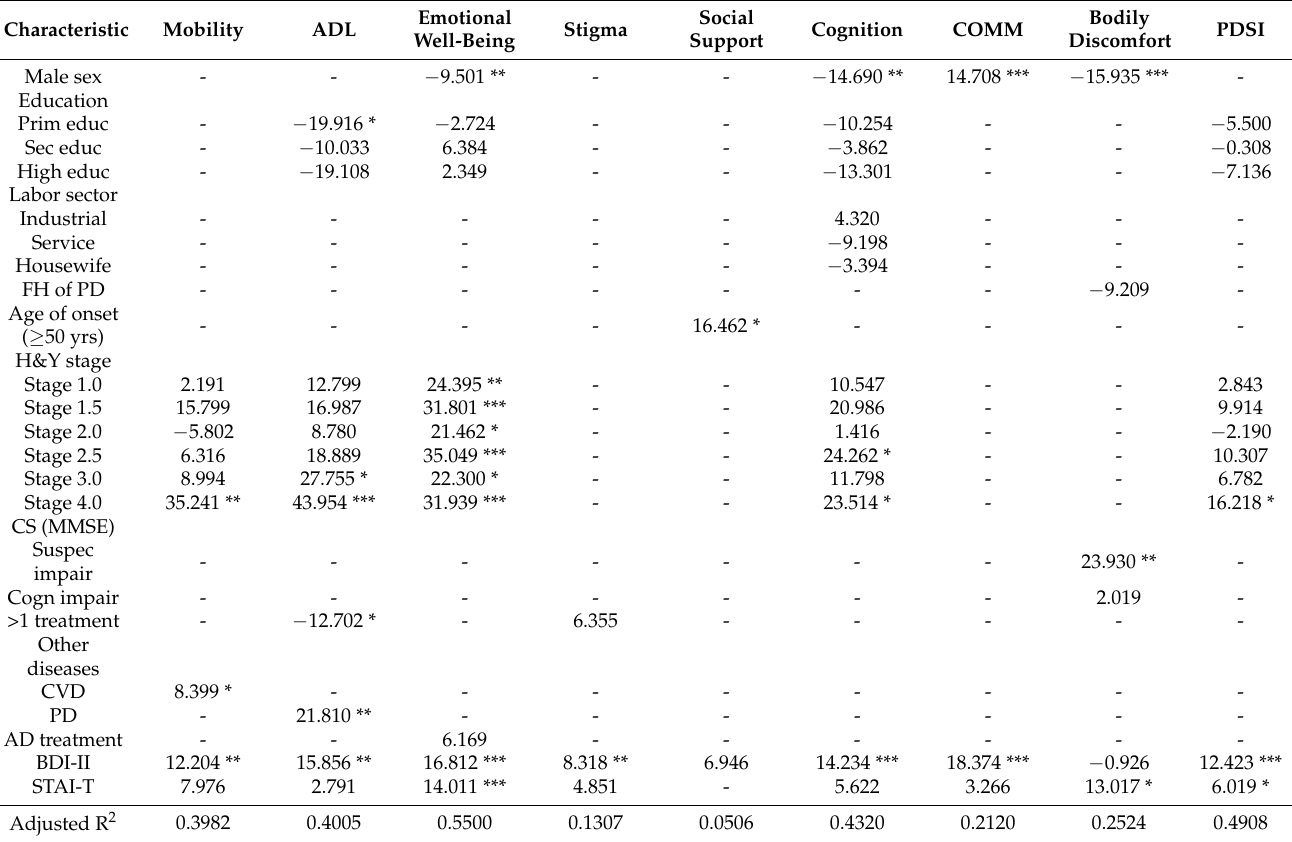
Table 4. Multivariate linear regression analysis of the dimensions of the PDQ-39 and PDSI. Significant values: * p < 0.05, ** p ≤ 0.01, *** p ≤ 0.001.